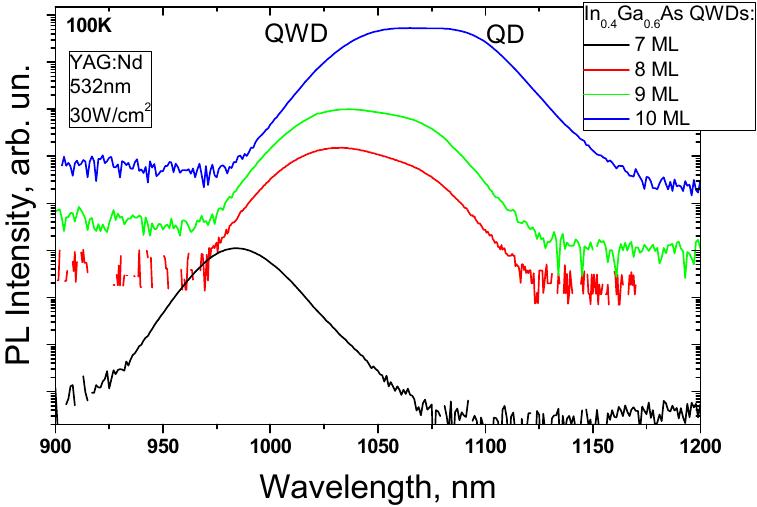
Figure 7. Evolution of the PL spectra of the QWDs with the increase in the nominal thickness of the deposited InGaAs from 7 ML to 10 ML, taken at 100 K.